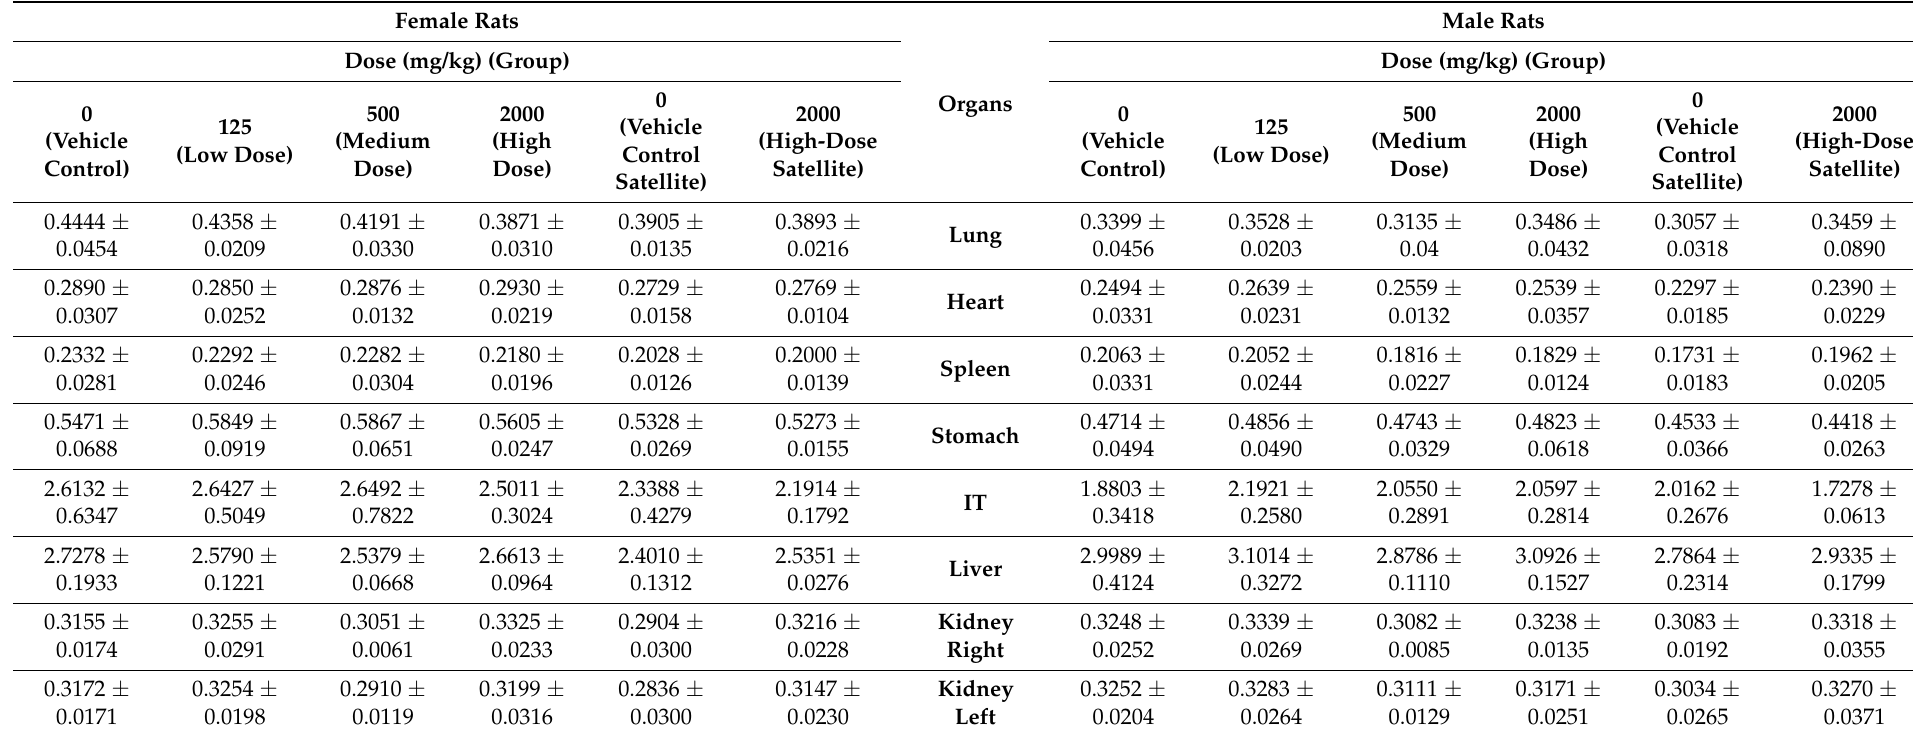
Table 10. Relative organ weight in female and male